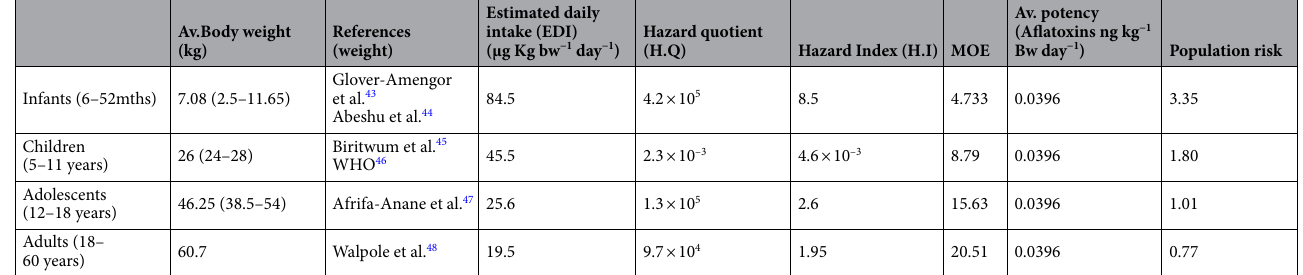
Table 10. Evaluation of risk for Aflatoxins B1 (AFB1) via consumption of maize. The margin of Exposure- MOE.